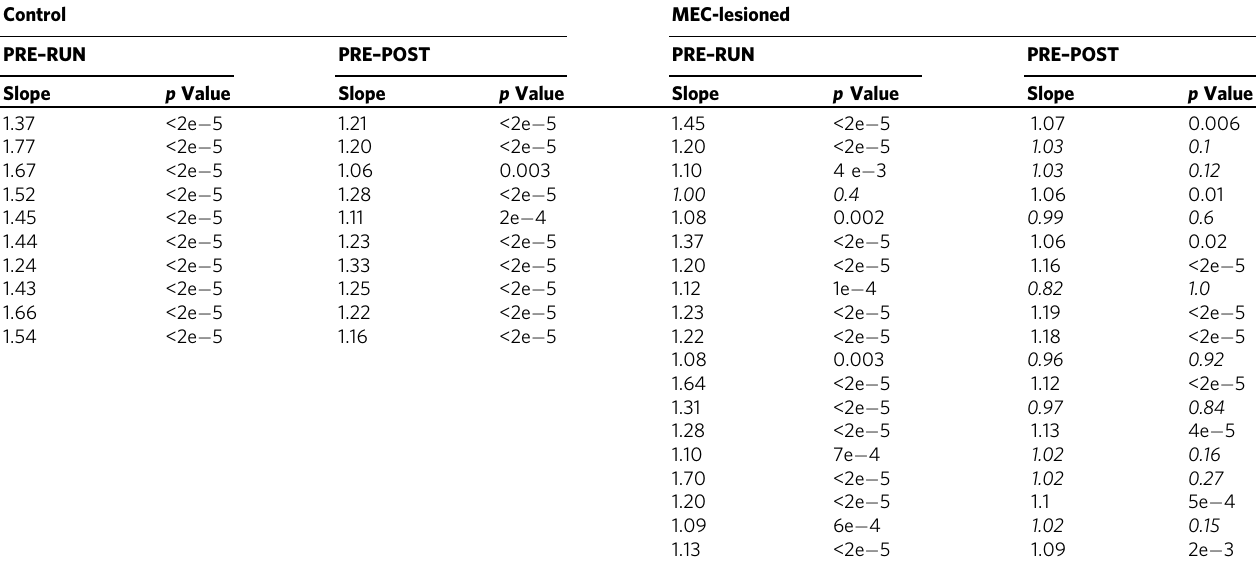
Table 1 Ampli fi cation of co-activation strengths as measured by regression slope